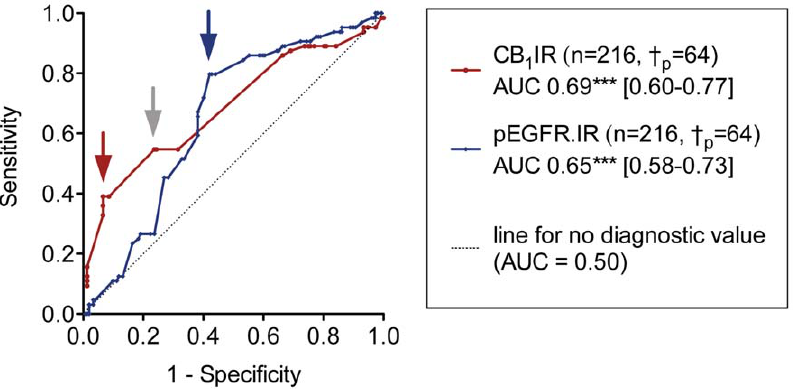
Figure 2. Receiver operating characteristic (ROC) curves for tumour CB 1 IR and pEGFR-IR. For each curve, the number of cases used in the analysis (which used a 15 year limit) together with the mean AUC value is shown. Values in square brackets are the 95% confidence intervals for the AUCs. { p refers to the number of cases who died as a result of the prostate cancer. The arrows show the part of the curve corresponding to the optimal cut-off values: red = Youden index for CB 1 IR, grey = least squares method for CB 1 IR, blue = both Youden and least squares method for pEGFR-IR (for details, see Results section of this paper).